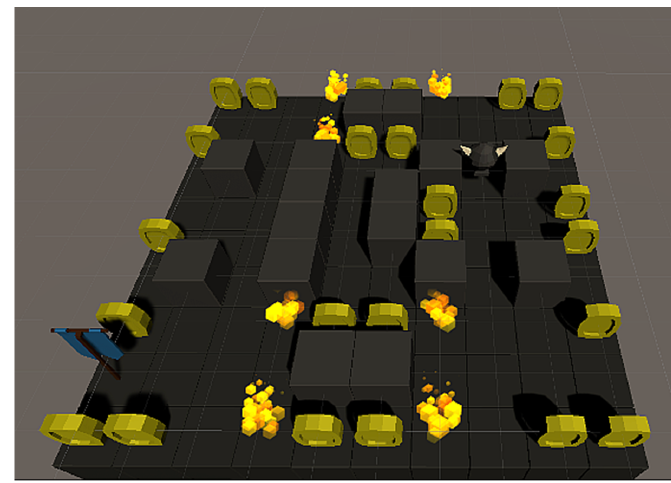
Figure 9. Room-like generated scene.